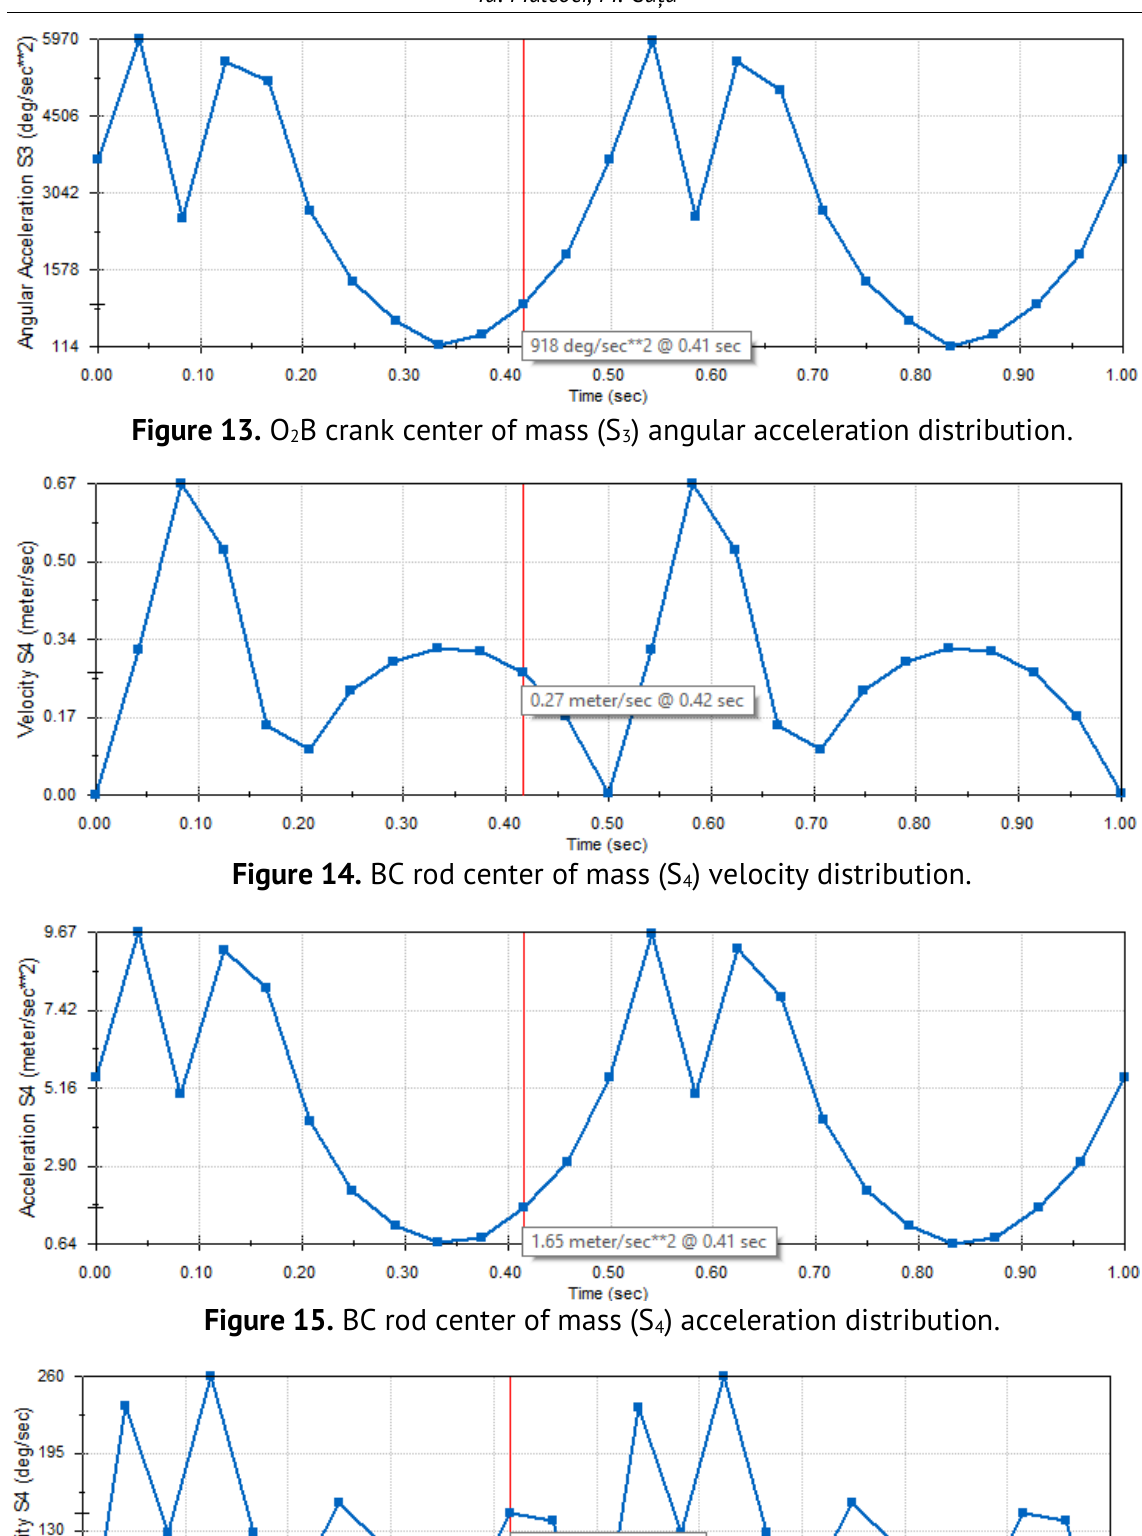
Figure 15. BC rod center of mass (S